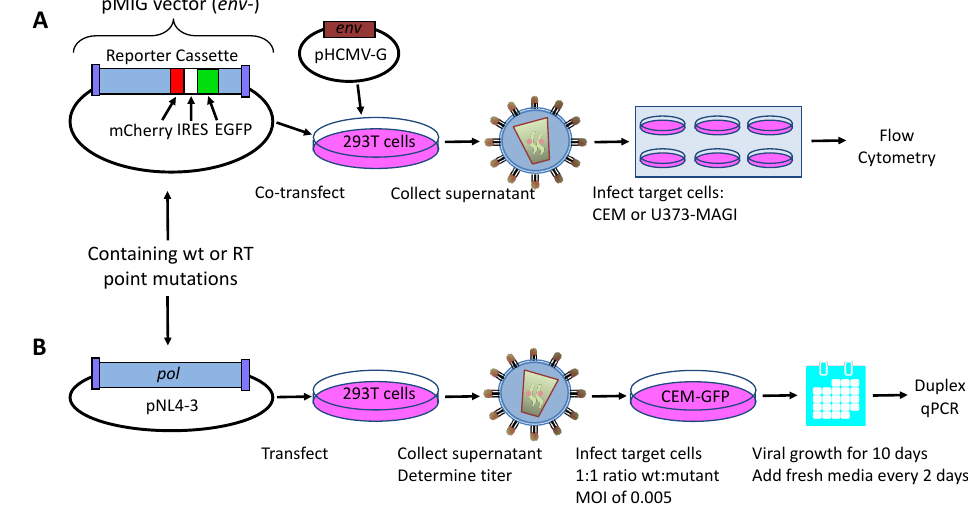
Figure 1. Assays for measuring human immunodeficiency virus type 1 (HIV-1) mutant frequencies and replication capacity. ( A ) Mutant frequency assay. 293T cells were co-transfected with an HIV-1 vector containing the dual-reporter mCherry and enhanced GFP (EGFP) cassette (pNL4-3 MIG) and a vesicular stomatitis virus G (VSV-G) envelope expression plasmid (pHCMV-G) in order to produce pseudotyped vector virus. Cell culture supernatants were collected and used to infect permissive CEM or U373-MAGI cells. Determination of virus mutant frequencies and replication capacities under zidovudine (AZT)-selective pressure were done using U373-MAGI cells. Relative infectivity and mutant frequencies were determined by flow cytometry. ( B ) Dual competition assay. Mutations in HIV-1 reverse transcriptase (RT) were introduced in an infectious molecular clone (pNL4-3), and were used to produce infectious virus following transfection of proviral DNA into 293T cells. Mutant and wild-type (wt) viruses were used to co-infect 5 × 10 5 permissive CEM-EGFP target cells at a 1:1 ratio, using a multiplicity of infection (MOI) of 0.005. Infected target cells were maintained for 10 days by replenishing with fresh media every other day. Cells were then collected, genomic DNA extracted, and relative amounts of viral nucleic acid quantified by duplex qPCR. Abbreviations: IRES, internal ribosome entry site; pol , HIV-1 gene consisting of protease, RT, and